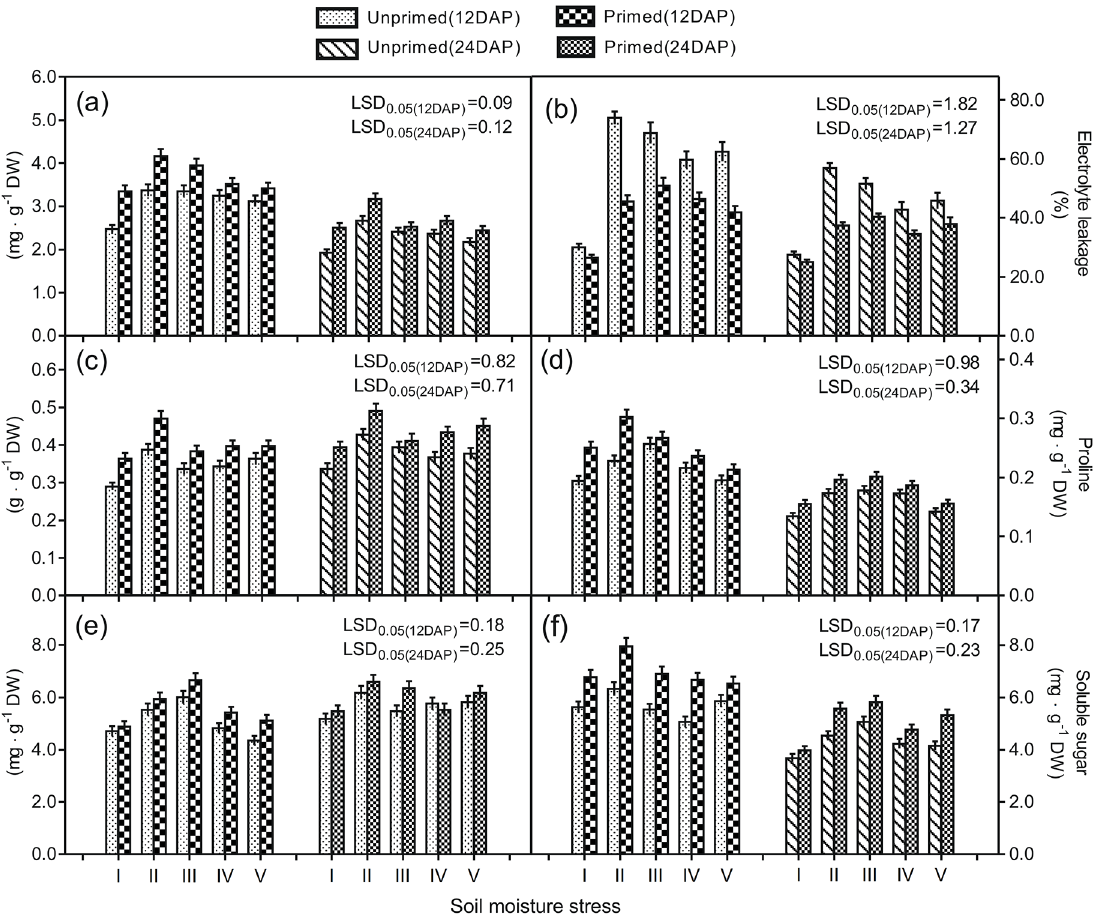
Fig 2. Effect of seed priming with PEG and soil moisture stress on sorghum free amino acid pool, proline, plasma membrane permeability, reducing sugar, soluble sugar, and soluble protein activities. (a) Free amino acid, (b) electrolyte leakage, (c) reducing sugar, (d) proline, (e) soluble protein, and (f) soluble sugar in sorghum seedlings. Unprimed or primed sorghum seeds were germinated under (I) unstressed soil moisture environment (Unstressed control), (II) drought, (III) excessive soil moisture stress (EM), (IV) 8 d drought stress followed by EM, and (V) 8 d EM followed by drought stress. Measurements were conducted at 12 and 24 days after planting (DAP). Data presented are means ± standard error.